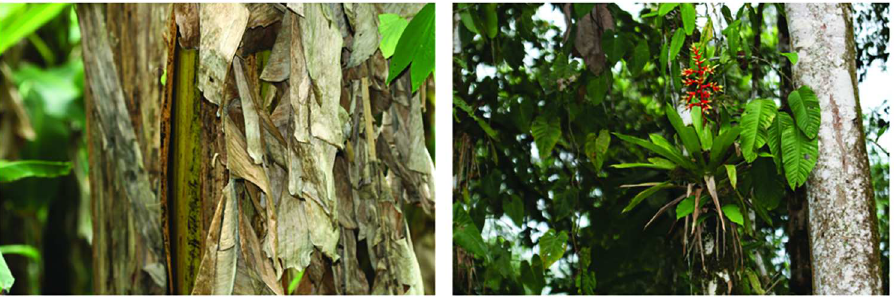
Fig 9. Microhabitat of Pristimantis ecuadorensis sp. nov. and P . ornatissimus sensu